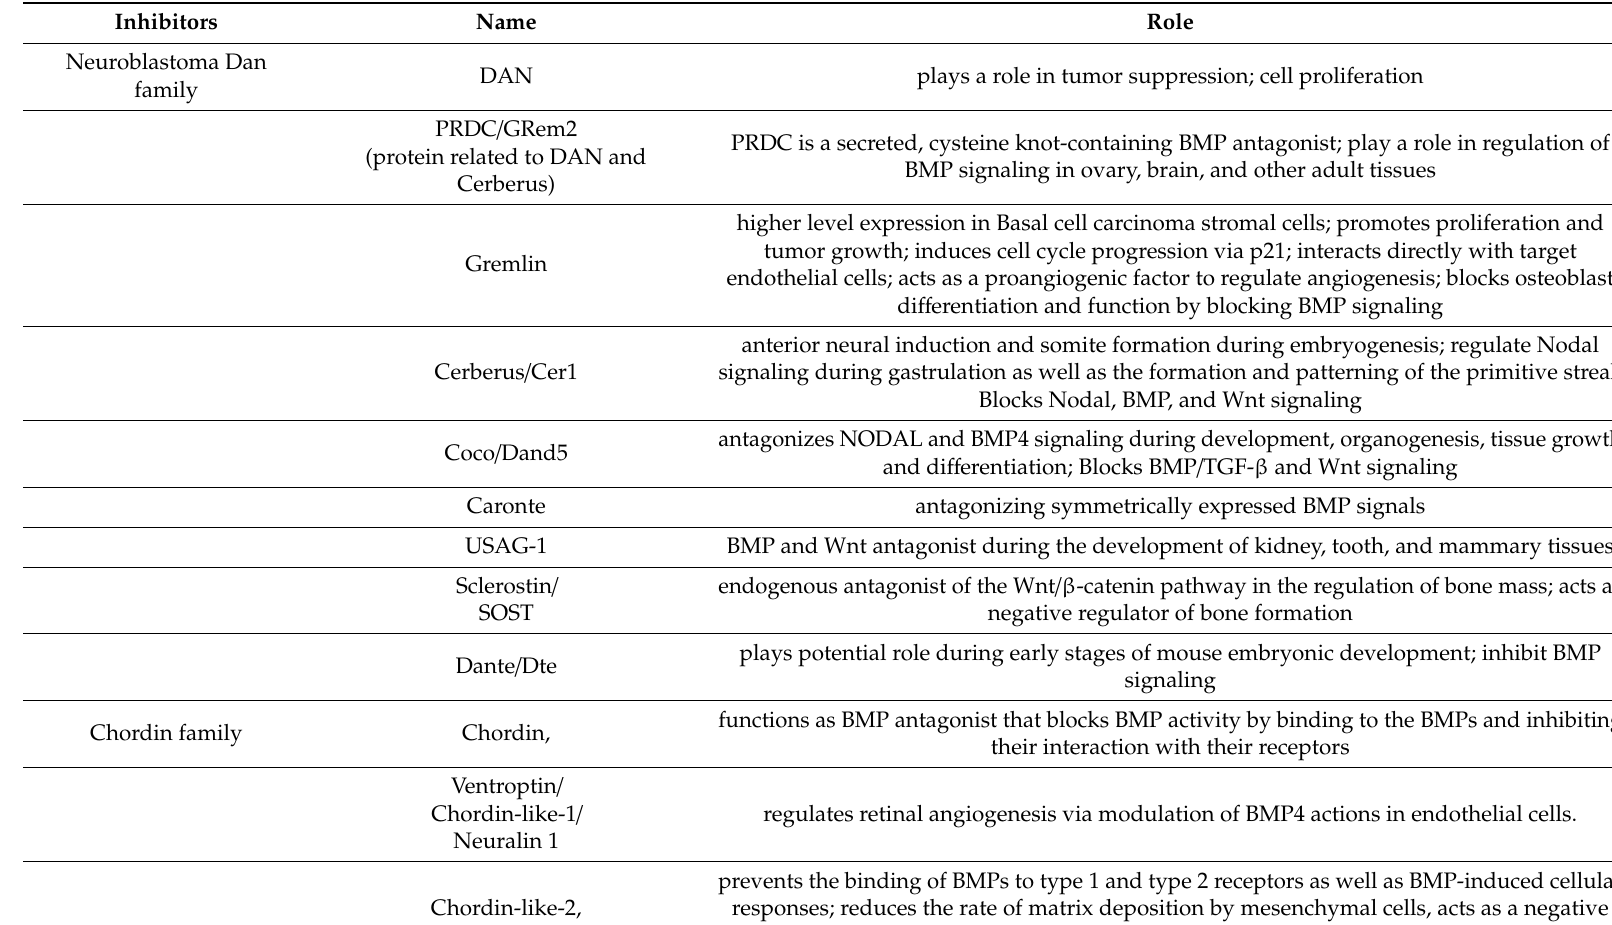
Table 2. Types of antagonists and their